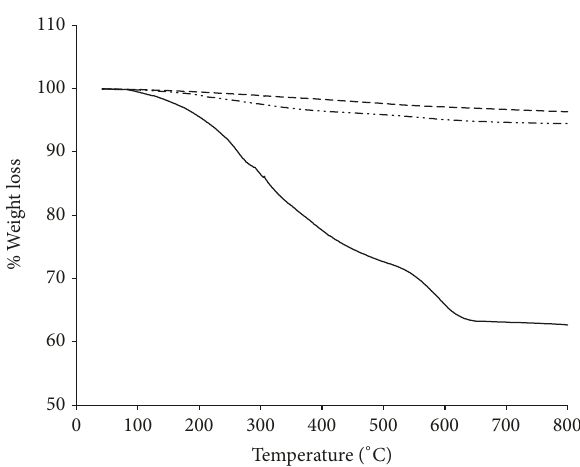
Figure 4: TGA curves: PNS (dashed curve) ; PNS-SS-ADA (double dashed dotted curve) ; PNS-SS-ADA@CD-mPEG (solid curve) . Figure 5: N